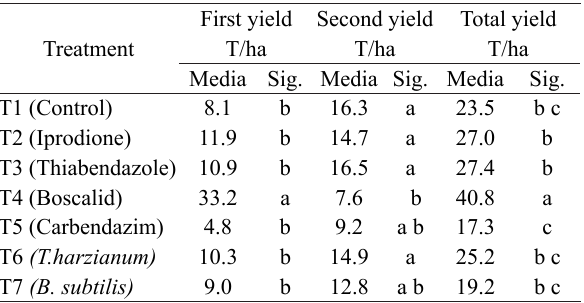
Table 8: Tukey´s comparison test for first and second quality yield and total yield in treatments.